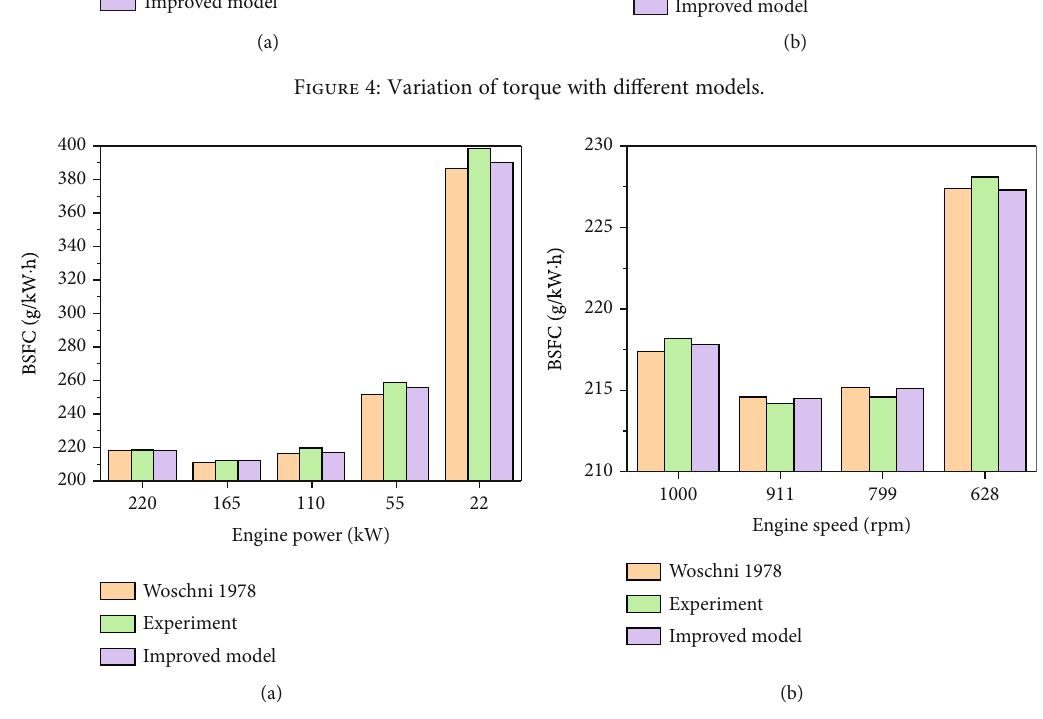
Figure 5: Variation of BSFC with di ff erent